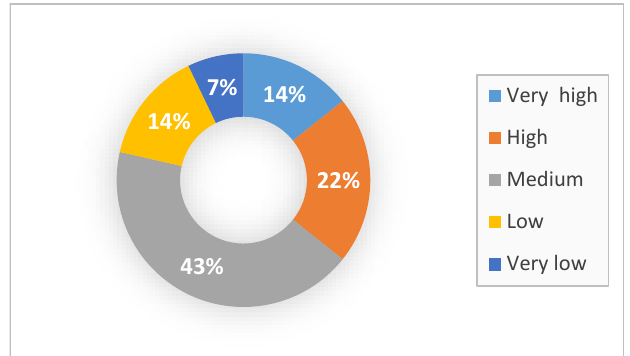
Figure 4. Impact of the GDPR implementation